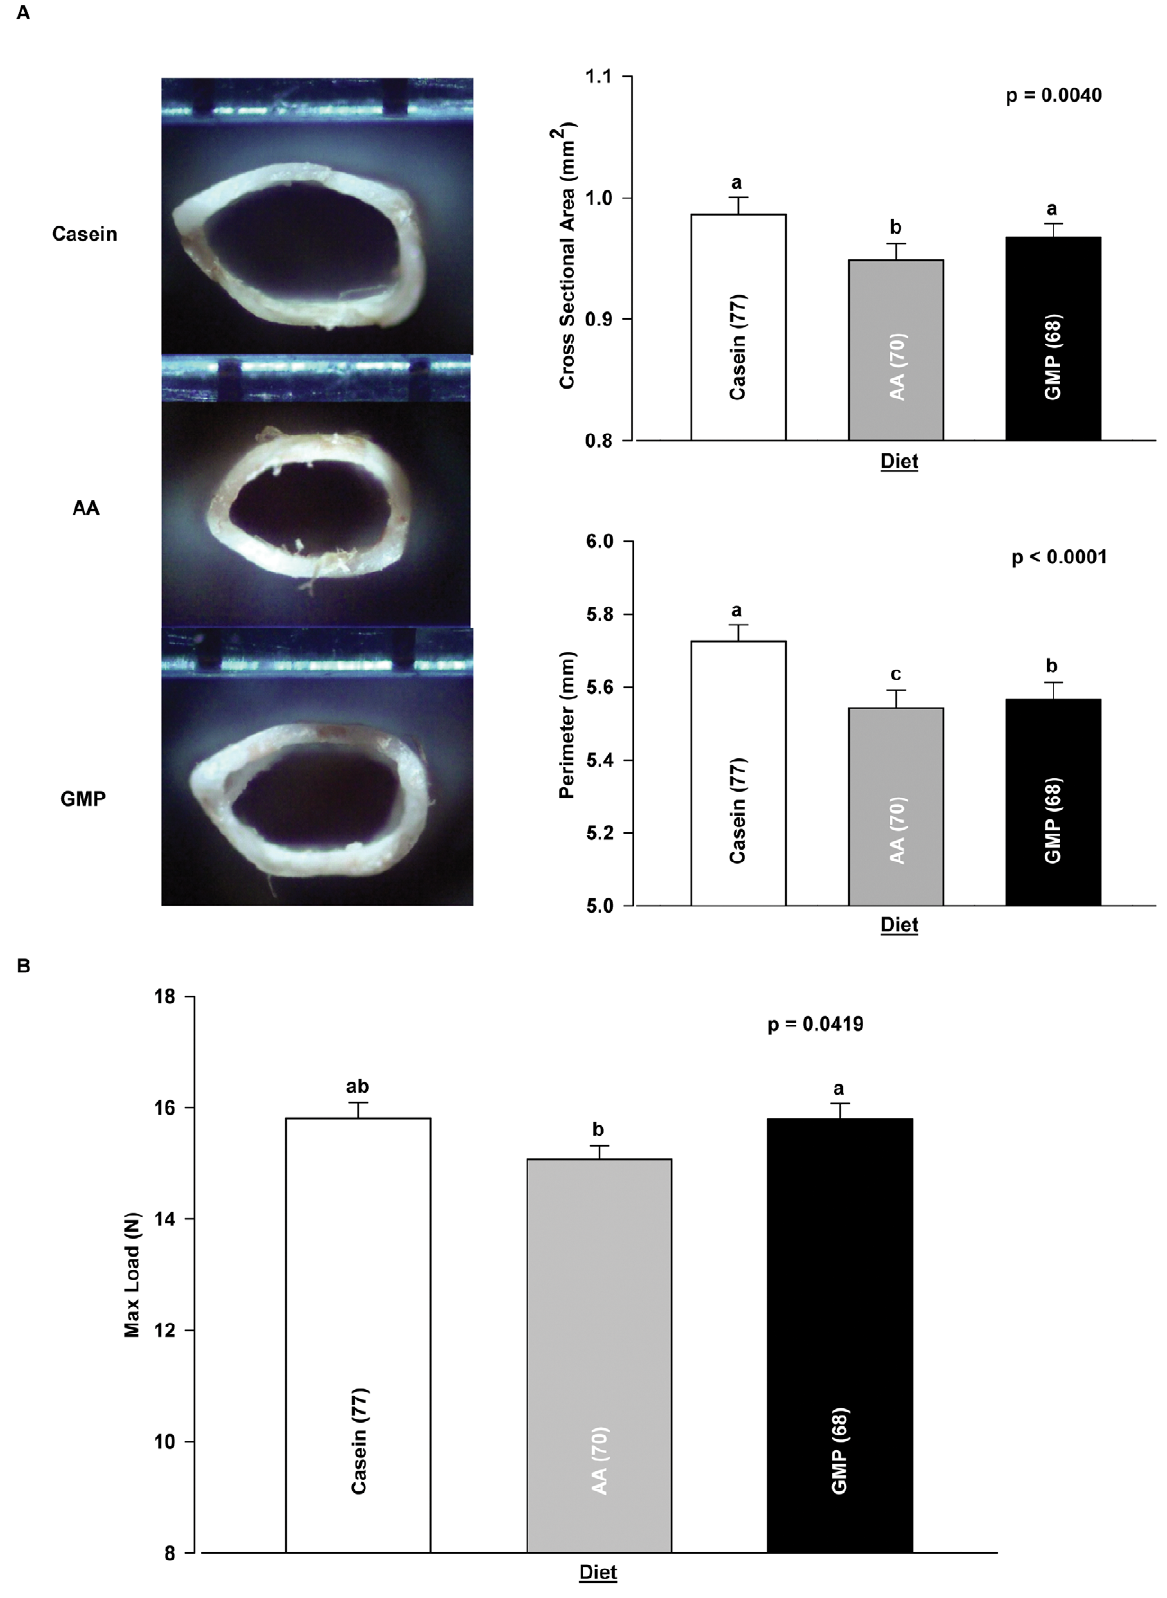
Figure 3. Diet modifies femoral size and strength in WT and PKU mice. Representative photographs of femoral cross-sectional geometry in mice fed casein, AA, and GMP diets from which measurements of cross-sectional area and perimeter are obtained (A). Diet effect on maximum load derived from load-displacement curve analysis (B). Values are means 6 SE; p-values represent main effect of diet. Sample size is shown in parenthesis. Groups with different letter superscripts are significantly different (p , 0.05). doi:10.1371/journal.pone.0045165.g003 PLOS ONE |